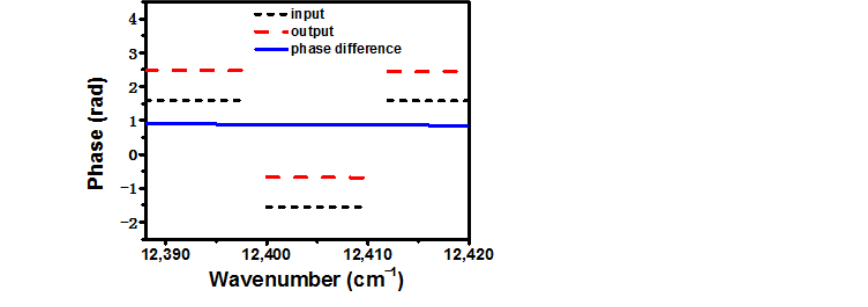
Figure 14. Schematic of the phases of the input, response, and the phase difference of the Stokes